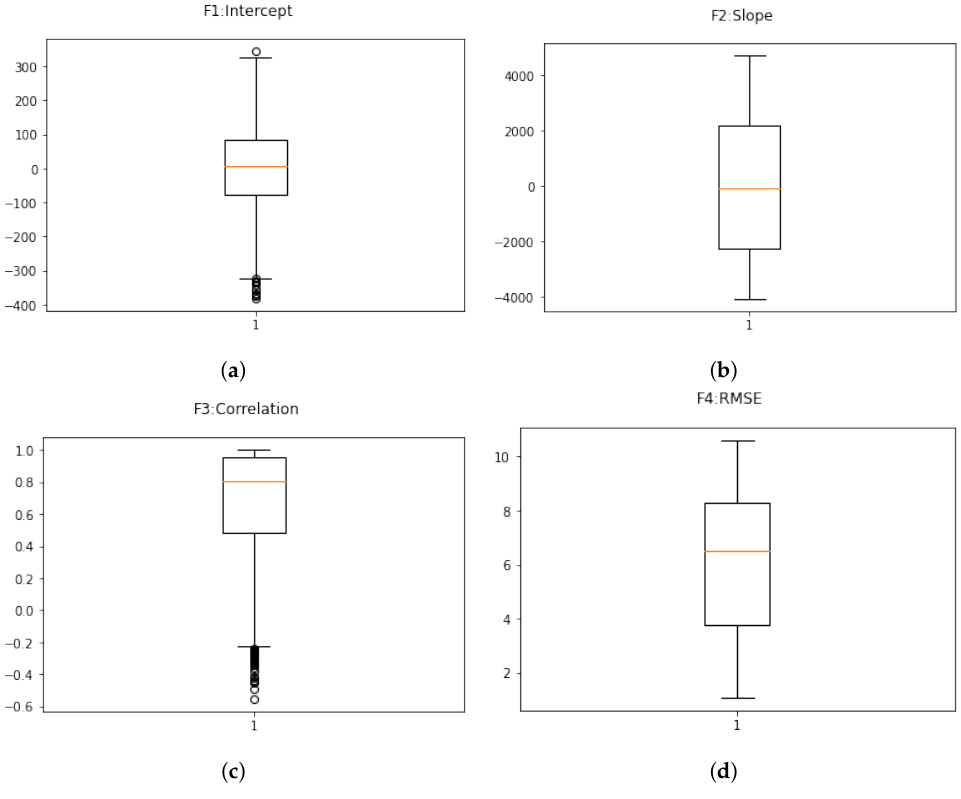
Figure 10. Box plot for each input feature in Dataset-4 (noise level from 5% to 20%). ( a ) m. ( b ) c. ( c ) R.